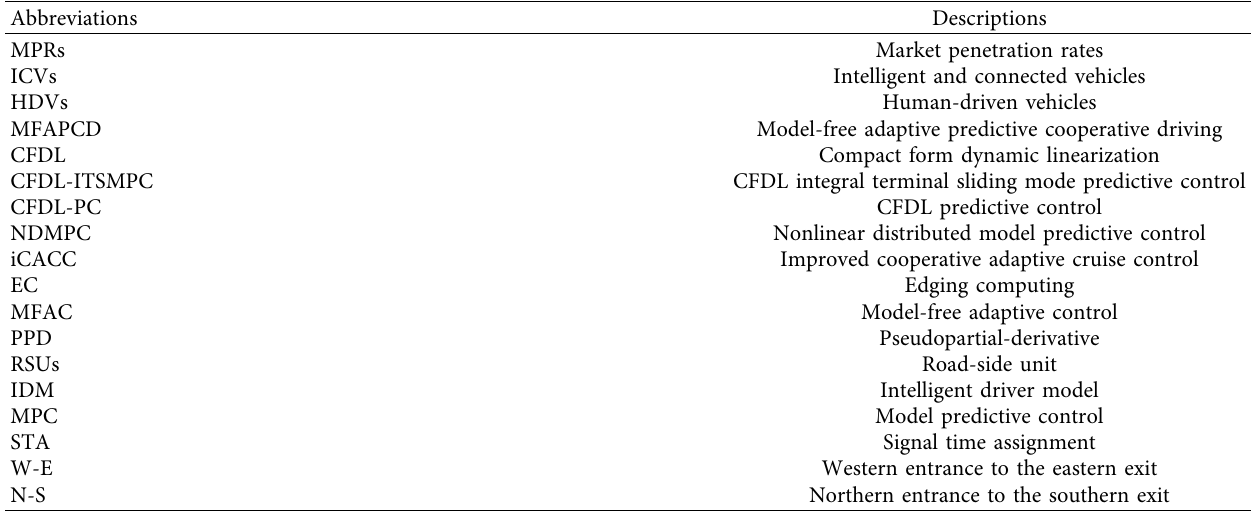
Table 1: Te major acronyms used in this paper.